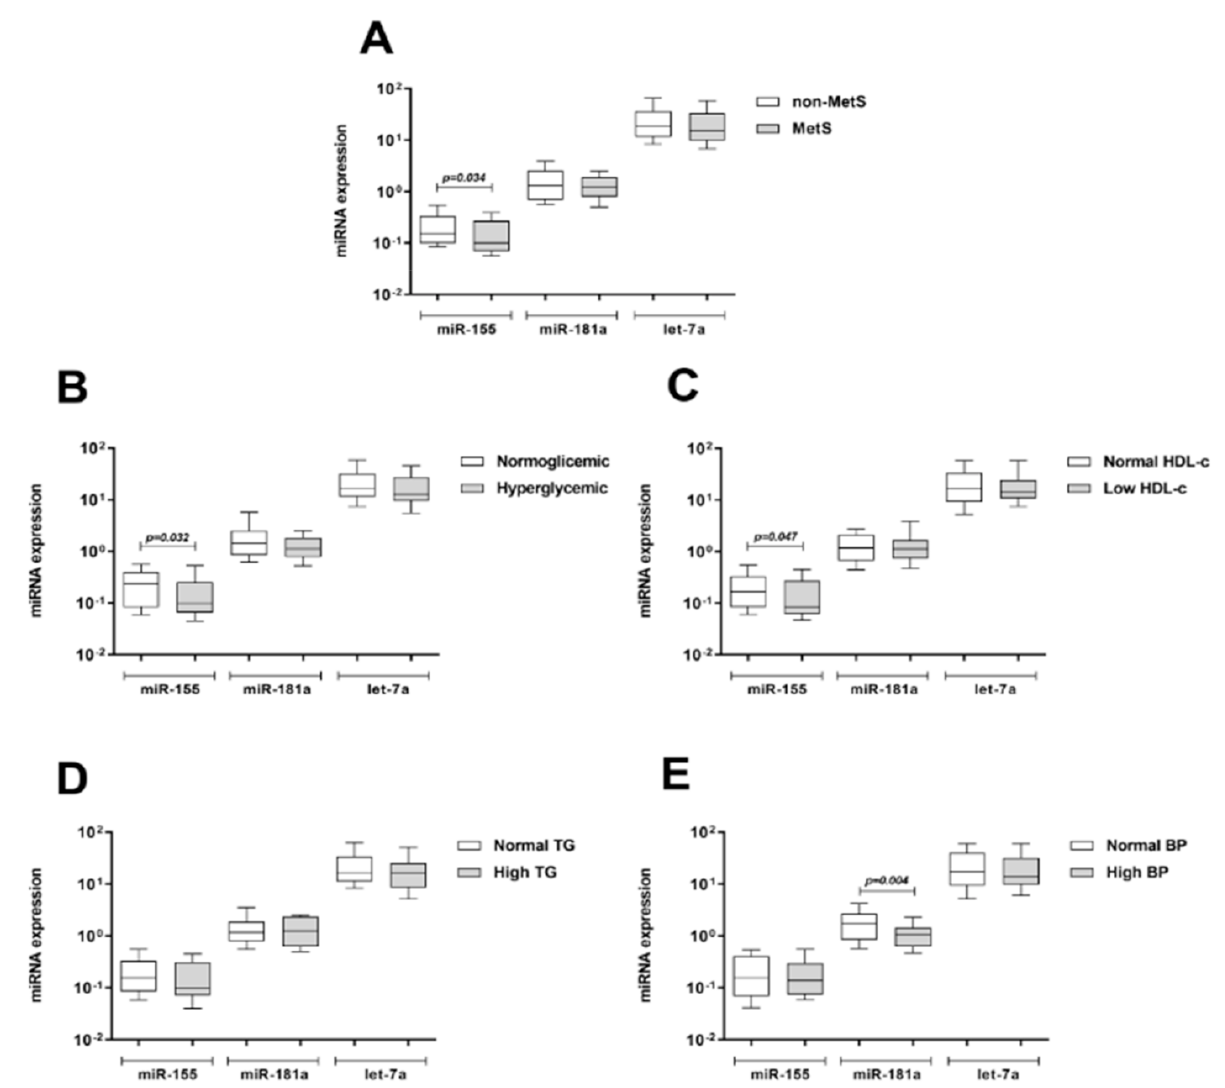
Figure 3. Expression of miR-155, miR-181a, and let-7a in peripheral blood of obese patients ( n = 80) (Validation study). Patients were grouped according to the MetS status ( A ) and according to the IDF criteria for MetS diagnosis: ( B ) Hyper- glycemia; ( C ) low HDL-c; ( D ) high triglycerides; and ( E ) high blood pressure. miRNA expression was measured using stem-loop Taqman RT-qPCR. Data are shown as box plots and were compared by Mann–Whitney U test. MetS: Metabolic syndrome; HDL-c: High-density lipoprotein cholesterol; TG: Triglycerides; BP: Blood